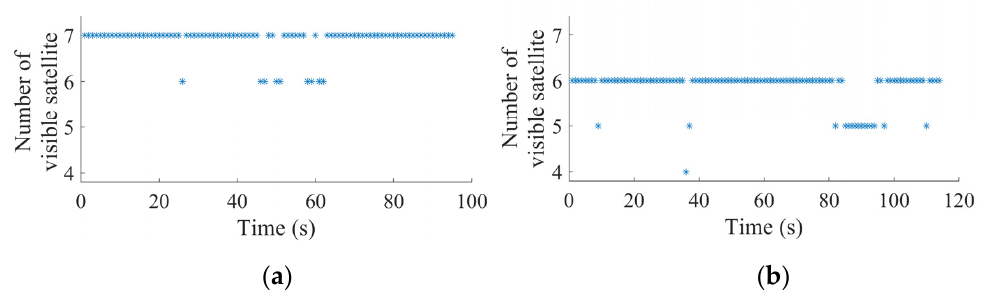
Figure 11. Number of visible satellites in dynamic tests, Wuhan. ( a ) Clockwise. ( b ) Counter-clockwise.